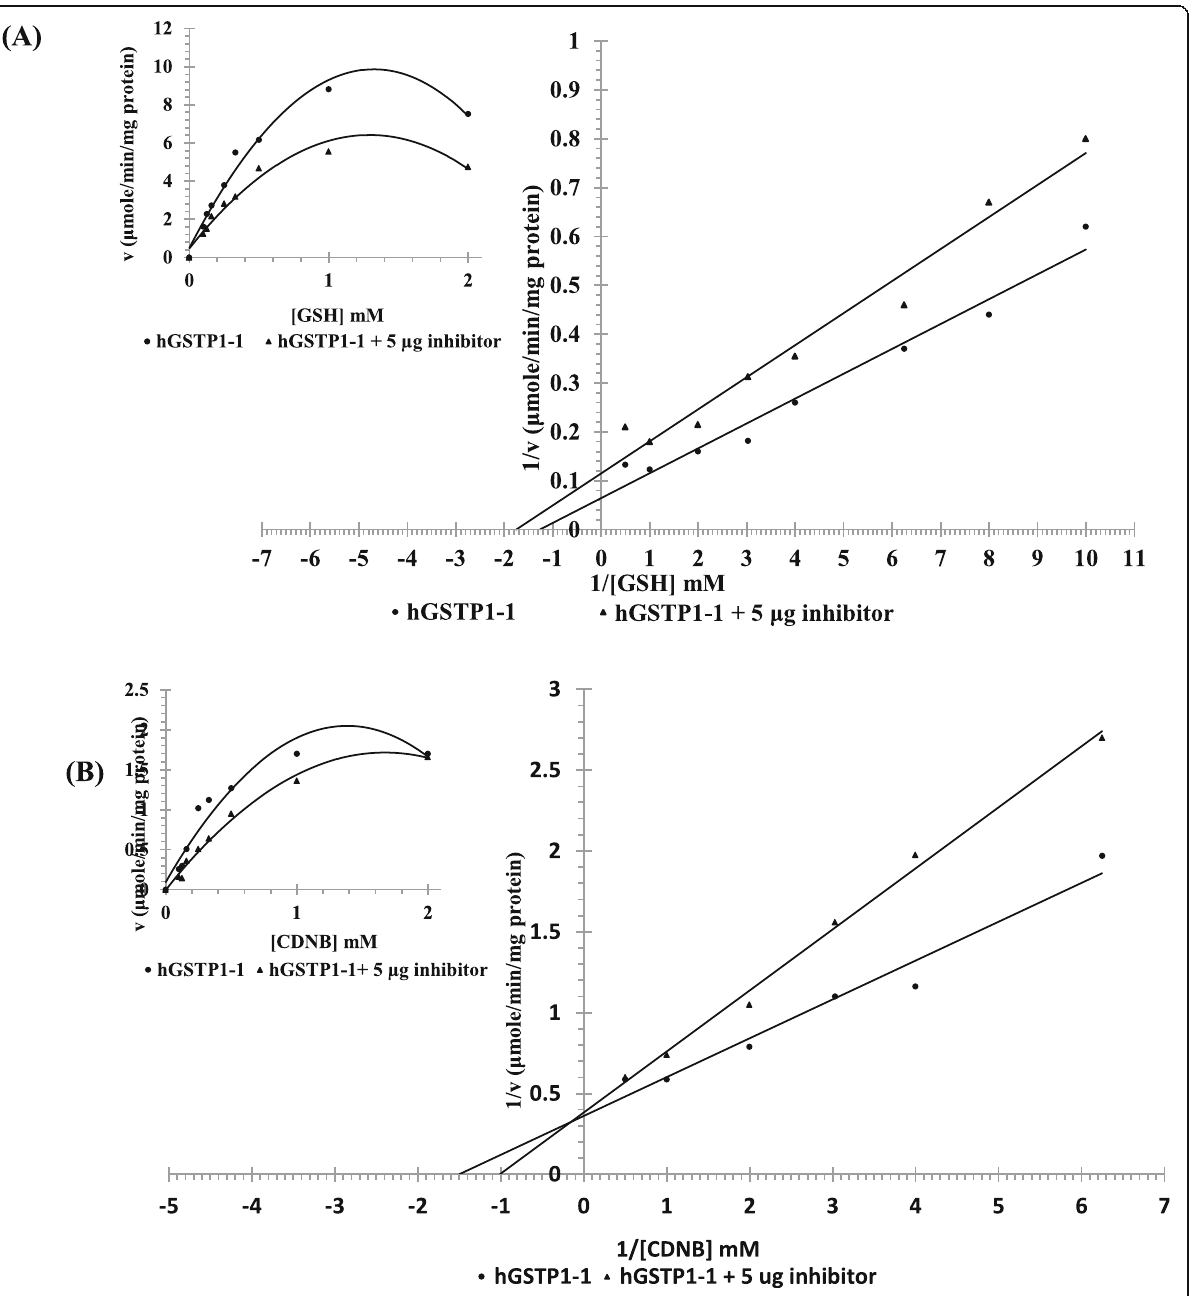
Fig. 1 a Effect of GSH concentration variation on the activity of hGSTP1-1 in the presence and absence of 5 μ g of T. indica n -butanol fraction. b Effect of CDNB concentration variation on the activity of hGSTP1-1 in the presence and absence of 5 μ g of T. indica n -butanol fraction. Both Michaelis-Menten and Lineweaver – Burk plot was shown of two substrates. The GSH concentration was varied between 0.1 ‑ 2 mM at fixed CDNB concentration (2 mM) in the presence and absence of 5 μ g of T. indica fraction ( a ). The CDNB concentration was varied between 0.625 ‑ 2 mM at constant GSH concentration (5 mM) in the presence and absence of 5 μ g of T. indica fraction ( b